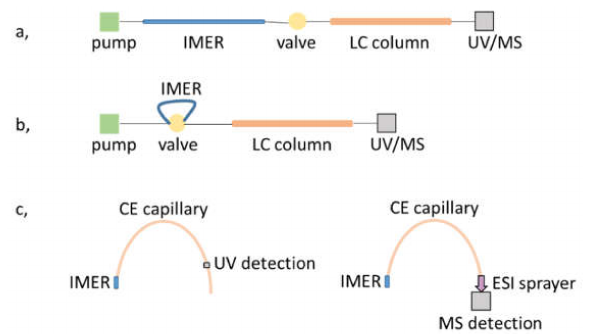
Figure 3. Schematic drawing of IMER-separation unit workflows for ( a , b ) LC and ( c ) CE platforms with UV and MS